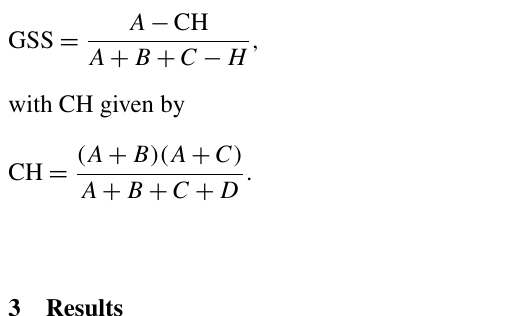
Table 2. Contingency table. 2 × 2 contingency table